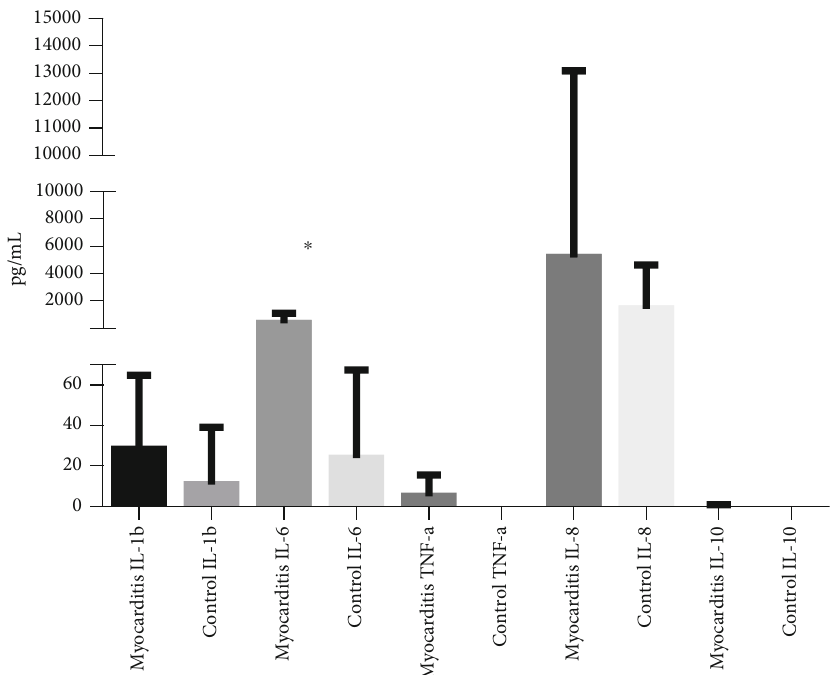
Figure 6: Cytokine levels in the plasma of patients with myocarditis and control subjects. The concentrations of the indicated cytokines were determined using fl ow cytometry in plasma from myocarditis patients and healthy subjects. ∗ p < 0 : 05 , ∗∗ p < 0 : 01